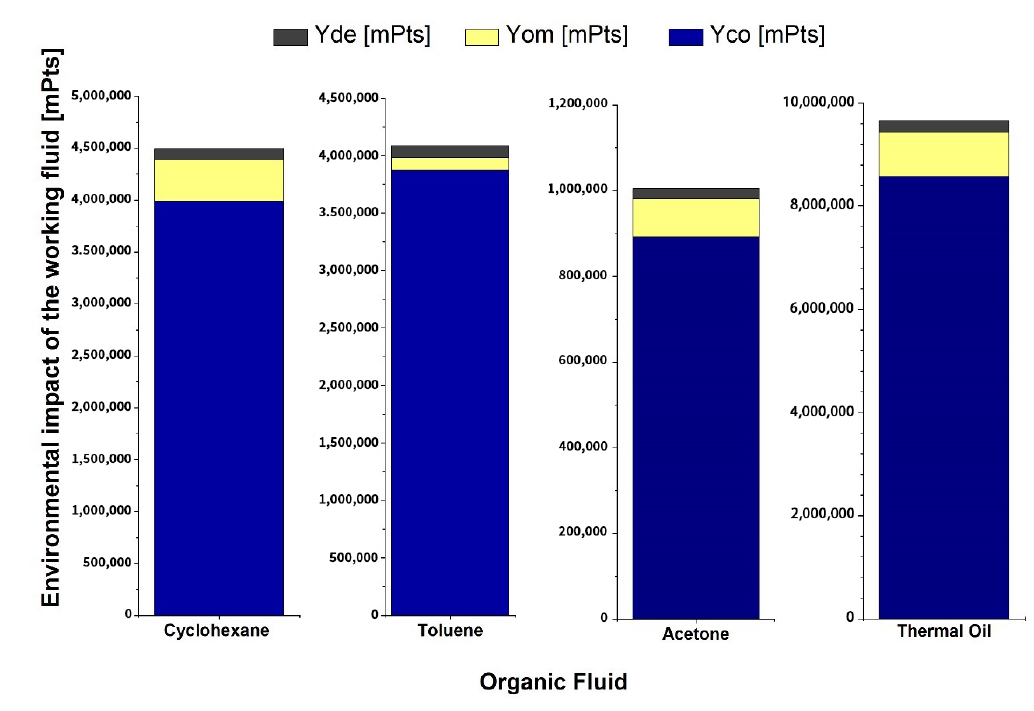
Figure 11. Environmental impact of the working